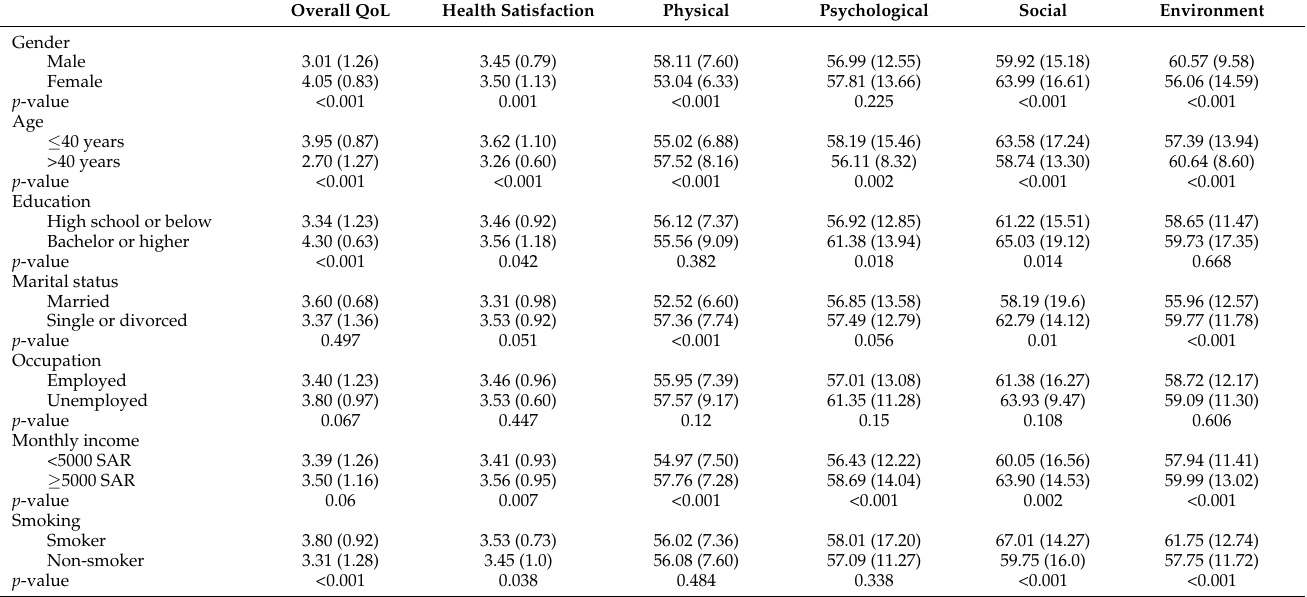
Table 6. The differences in WHOQOL-BREF domain scores across sociodemographic